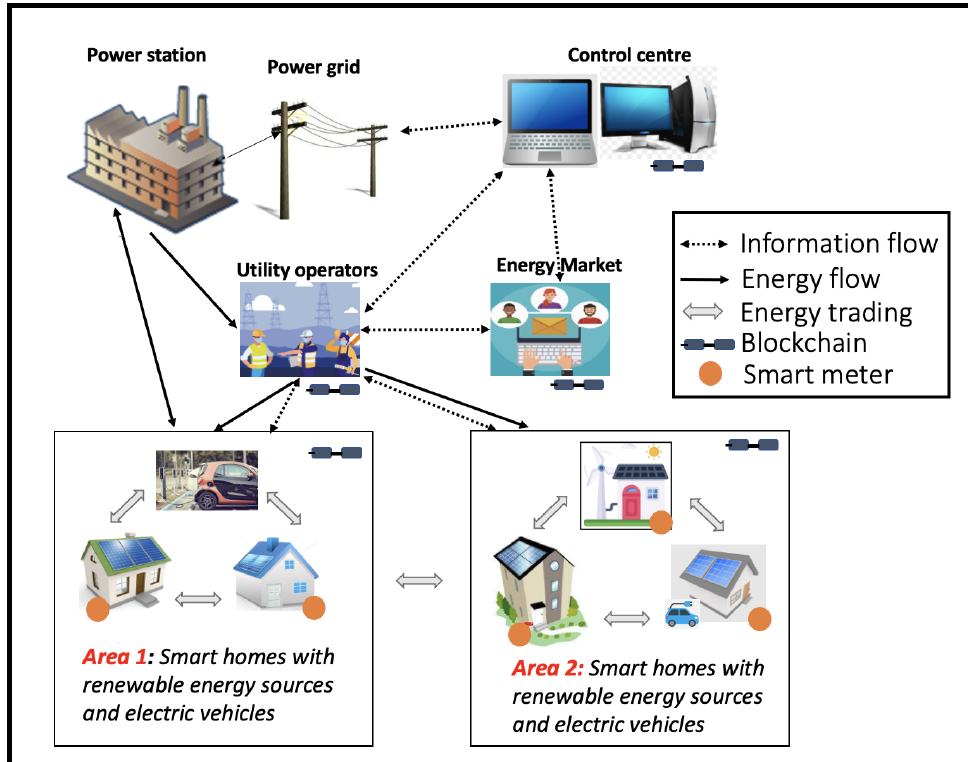
Figure 9. Blockchain-enabled future smart